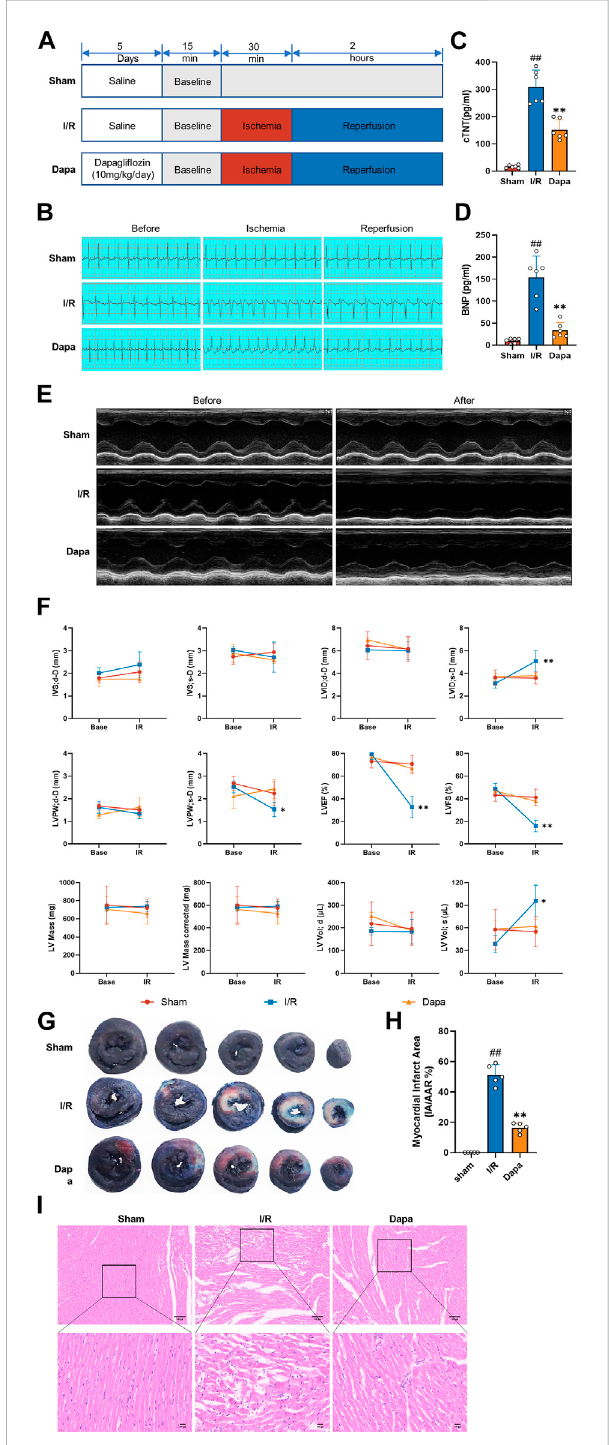
FIGURE 5 The protective effect of dapagli fl ozin on myocardial I/R injury in vivo . (A) Experimentalprotocols. (B) TypicalECGsegmentsinthebasic state after 30 min of ligation and reperfusion for 2 h (C, D) cTnT and BNP concentrations in each group were detected by ELISA kit ( n = 6 per group). (E) Representative transthoracic echocardiography images of the basal state and after reperfusion. (F) Cardiac echocardiography parameters of the experimental rats, including IVS, LVID, LVPW, LVEF (%), LVFS(%), LV mass and volume ( n = 5 per group). (G) Representative cross-section images of Evans Blue/TTC double-